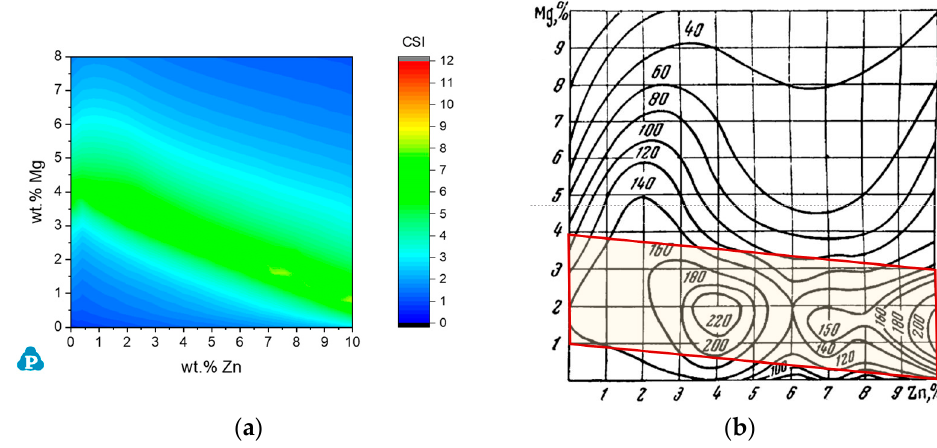
Figure 7. Al-Mg-Zn-0.5Cu cracking susceptibility maps: ( a ) by improved Scheil model considering back diffusion in the solid under the cooling rate of 20 °C/s and ( b ) experimentally tested data [56] (Reprinted with permission from ref. [4]. Copyright 2004 Elsevier).